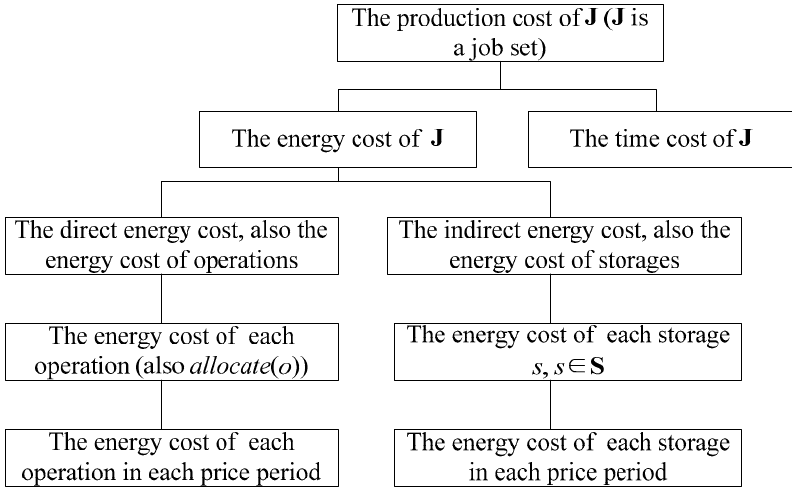
Figure 2. Breakdown model of the production cost.